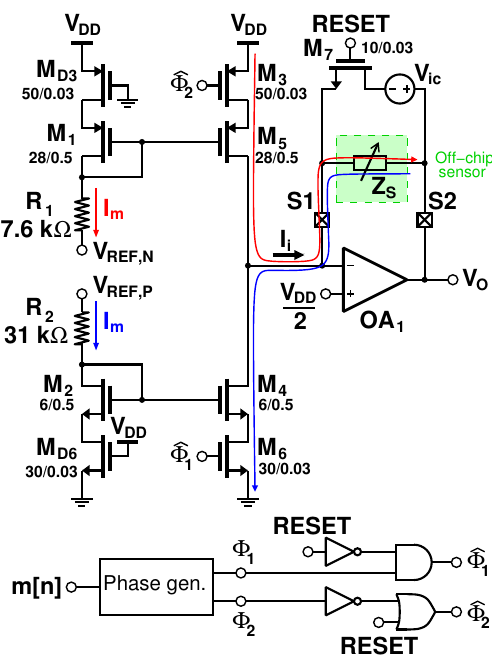
Figure 3. Circuit schematic of the implemented AFE. The specified width/length are reported in µm for each